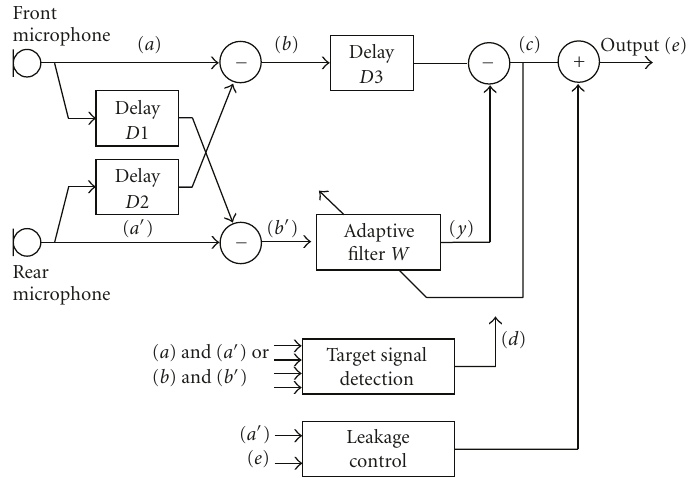
Figure 1: Block diagram of the two-microphone noise reduction system with nearby